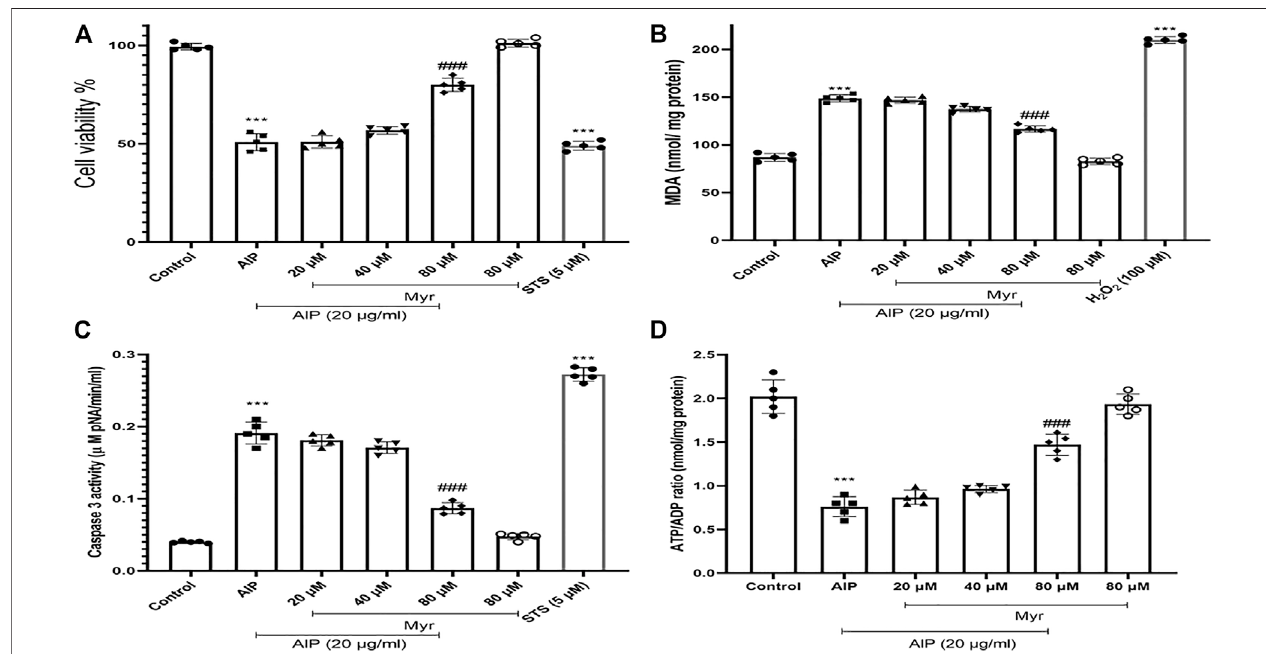
FIGURE 1 | Ameliorative effect of Myr on AlP-induced cytotoxicity in isolated cardiomyocytes. (A) Isolated cardiomyocytes were treated or cotreated with the indicated concentrations (20 μ g/ml) of AlP and Myr (20, 40, and 80 µM) for 3 h. Cell viability was examined after incubation using MTT assay. Myr inhibits AlP-induced cytotoxicity in isolated cardiomyocytes. (B) Isolated cardiomyocytes were treated or cotreated withMyr (20, 40, and 80 μ M) and AlP (20 μ g/ml) for3 h. MDA production was measured by production of thiobarbituric acid (TBA) reactive substances (TBARS). (C) Isolated cardiomyocytes (10 6 cells/ml) were incubated in CCT medium in conventional condition (37 ° C and 5% CO 2 -air) for 3 h. Caspase-3 activity was determined by Sigma-Aldrich kit. Columns represent caspase-3 activity ( μ M pNA/min/ ml) inisolated cardiomyocytes. (D) ATP/ADP ratioswere determined by Luciferin/Luciferase assayas described in the Materials and Methods . Values representmean ± SD ( n (cid:2) 3) of three independent experiments. *** p < 0.001 versus control; ### p < 0.001 versus AlP-treated cardiomyocytes, one-way ANOVA, Tukey ’ s test. Myr, myricetin; AlP, aluminum phosphide; MDA, malondialdehyde; STS, staurosporine; CCT, creatine – carnitine –